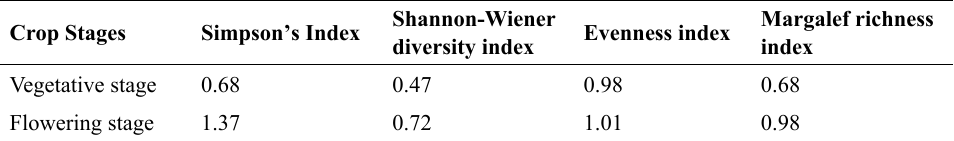
Table 3. Diversity indices of leafcutter bees Megachile Latreille, 1802 in different crop stages of Pigeon pea ( Cajanus cajan (L.) Millsp., Fabaceae) in the experimental farm of ICAR-National Bureau of Agricultural Insect Resources (NBAIR) Bengaluru, Yelahanka Campus,